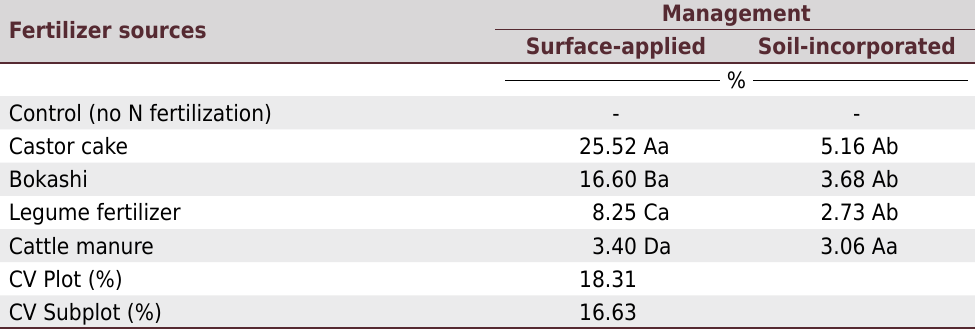
Table 3. Ammonia volatilization rate from different fertilizers applied to snap bean in winter/spring Fertilizer